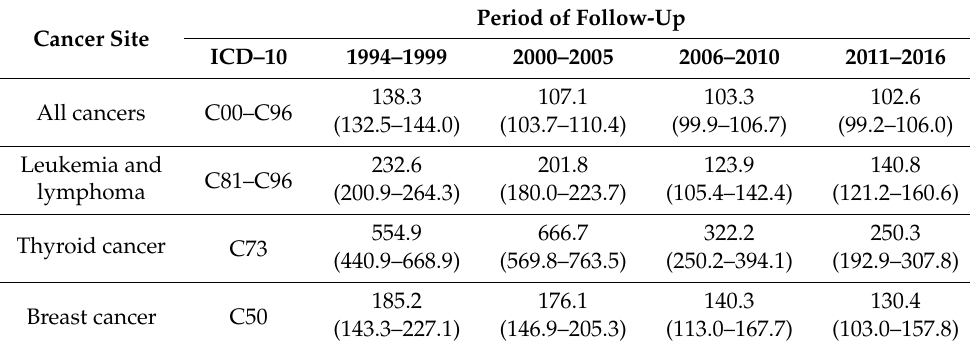
Table 1. Cancer standardized incidence ratios, SIRs, (95% CI), in Ukrainian Chornobyl cleanup workers (1986–1987, both genders) by follow-up period and cancer